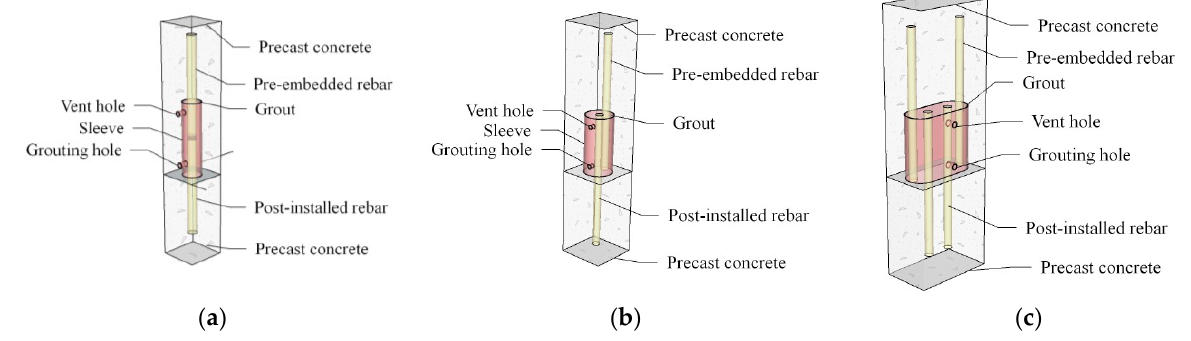
Figure 1. Schematic of grouted sleeve connector: ( a ) grouted splice connector; ( b ) type-I grouted lapping connector; and ( c ) type-II grouted lapping connector.